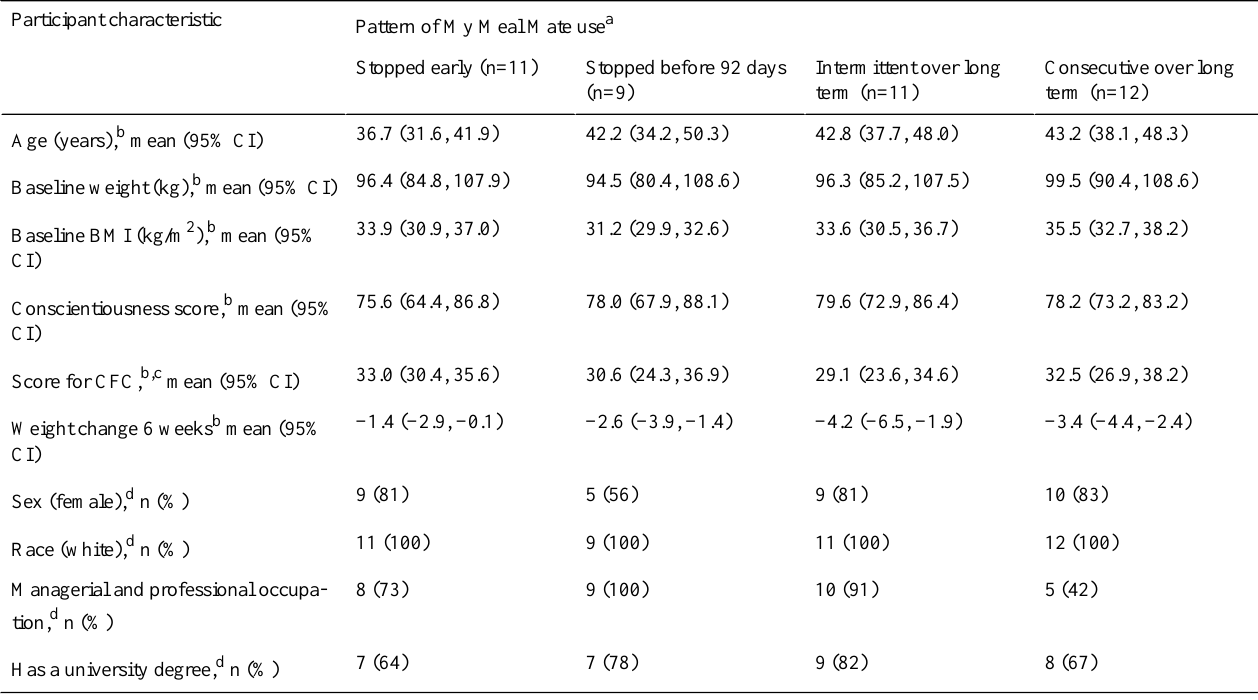
Table 4. Investigation of the differences between patterns of My Meal Mate use for key variables measured at baseline in the My Meal Mate group. Pattern of My Meal Mate use a Participant characteristic